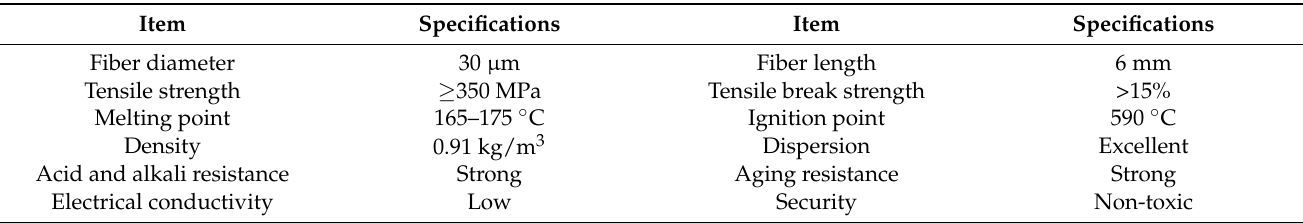
Table 5. Main technical indexes of polypropylene fiber.